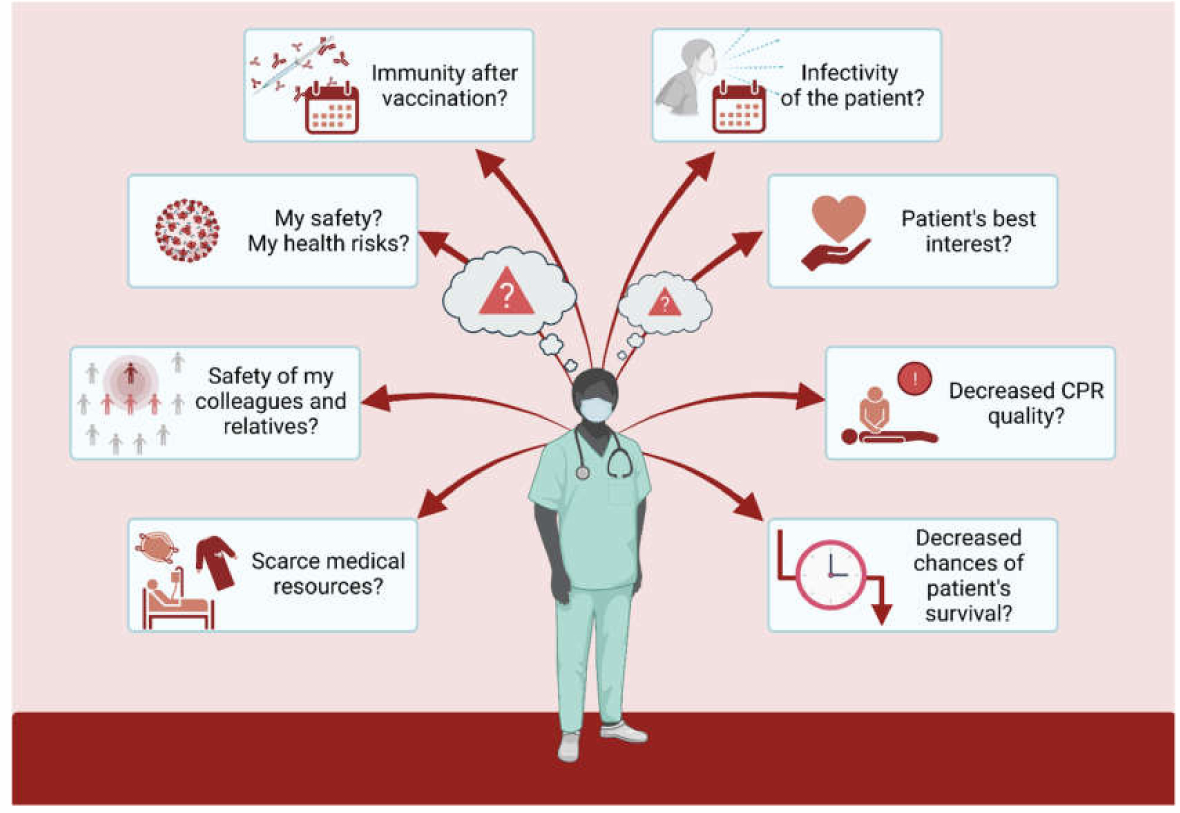
Figure 5. Dilemmas regarding uncertainties around cardiopulmonary resuscitation in times of COVID-19, faced by medical